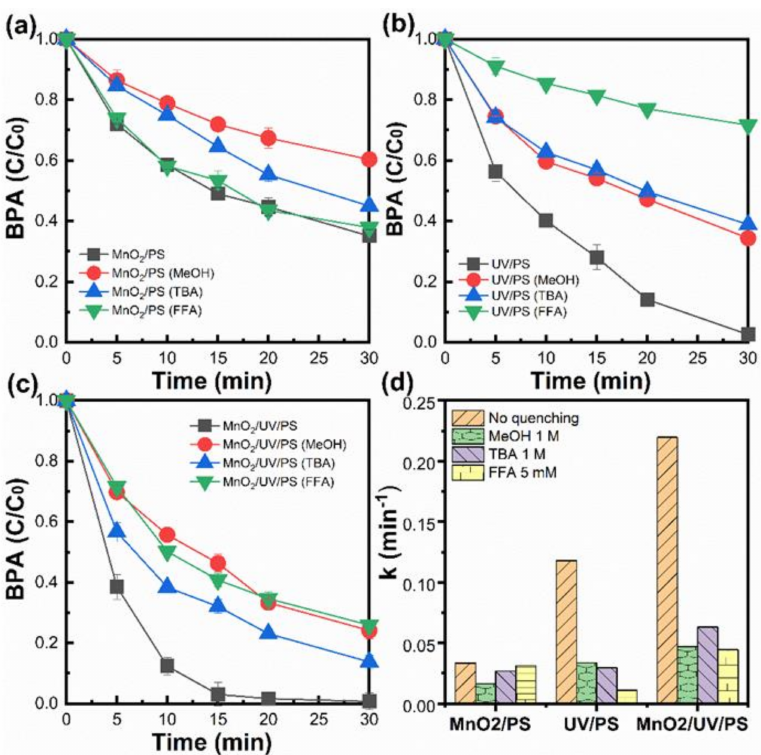
Figure 4. Effects of radical inhibitors on BPA concentrations over 30 min for ( a ) MnO 2 /PS, ( b ) UV/PS, and ( c ) MnO 2 /UV/PS processes, and ( d ) the effects these inhibitors have on the process rate constants. Initial conditions: [BPA] = 30 mg/L, pH = 6.5, [PS] = 1 mM, [MnO 2 ] = 0.25 g/L. When an inhibitor is used, initial [MeOH] = 1 M or [TBA] = 1 M or [FFA] = 5